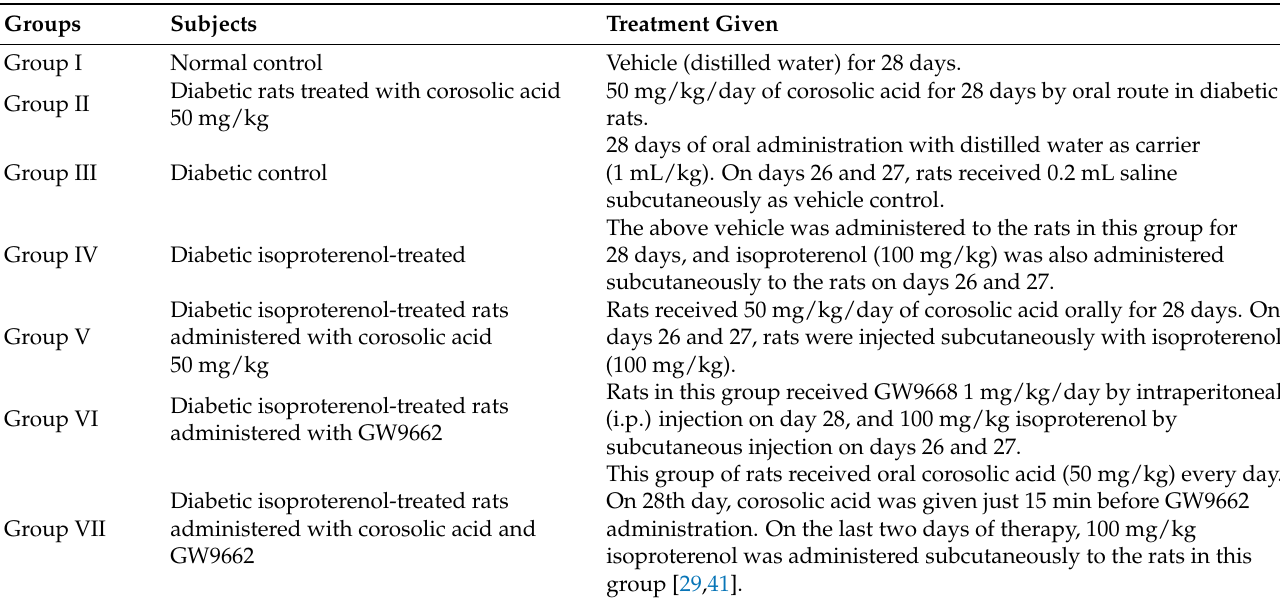
Table 3. Grouping of